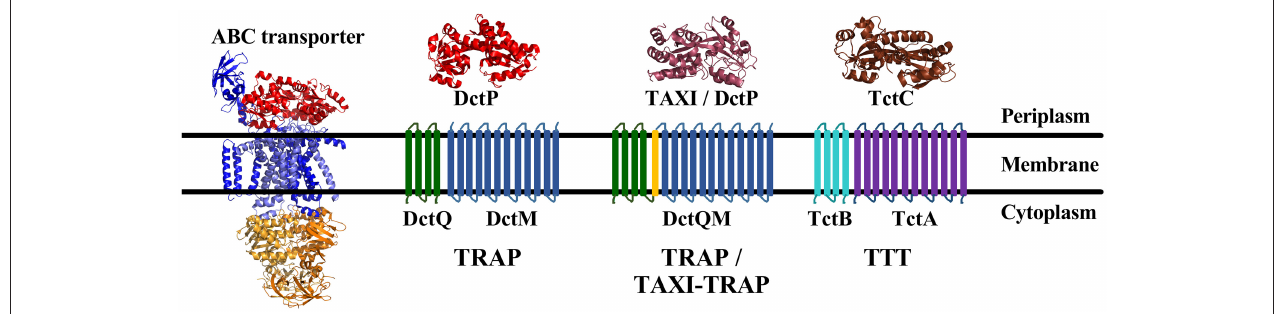
FIGURE 1 | Overall topologies and structures of the different Solute Binding Protein (SBP dependant) transporter families. The ABC transporters are represented by the E. coli maltose transporter MalEFGK2 (PDB 2R6G). It is composed of a solute binding protein (red), two Transmembrane (TM) domains (blue), and two Nucleotide binding domains (NBD) (orange); The secondary Tripartite ATP-independent periplasmic (TRAP) Transporters are composed of a 12 TM domain channel DctM (blue) and a 4 TM domain protein DctQ (green), which can be fused together by an additional TM domain (yellow) in a DctQM protein, and a DctP or TAXI SBP protein, represented respectively by the SiaP from H. influenza (PDB 2CEY) (light red) and the TT1099 from T. thermophilus (PDB 1US4) (dark red). TAXI-TRAP were always found associated with fused DctQM proteins; The Tripartite Tricarboxylate Transporter (TTT), is formed also by a 12 TM channel TctA (purple), a 4 TM protein TctB (cyan) and a TctC solute binding protein, represented by Bug27 from B. pertussis (PDB 2QPQ) (Brown). In some rare cases, TctAB proteins may be also fused. Although sharing similar topology, the TRAP and TTT systems share no sequence similarity.